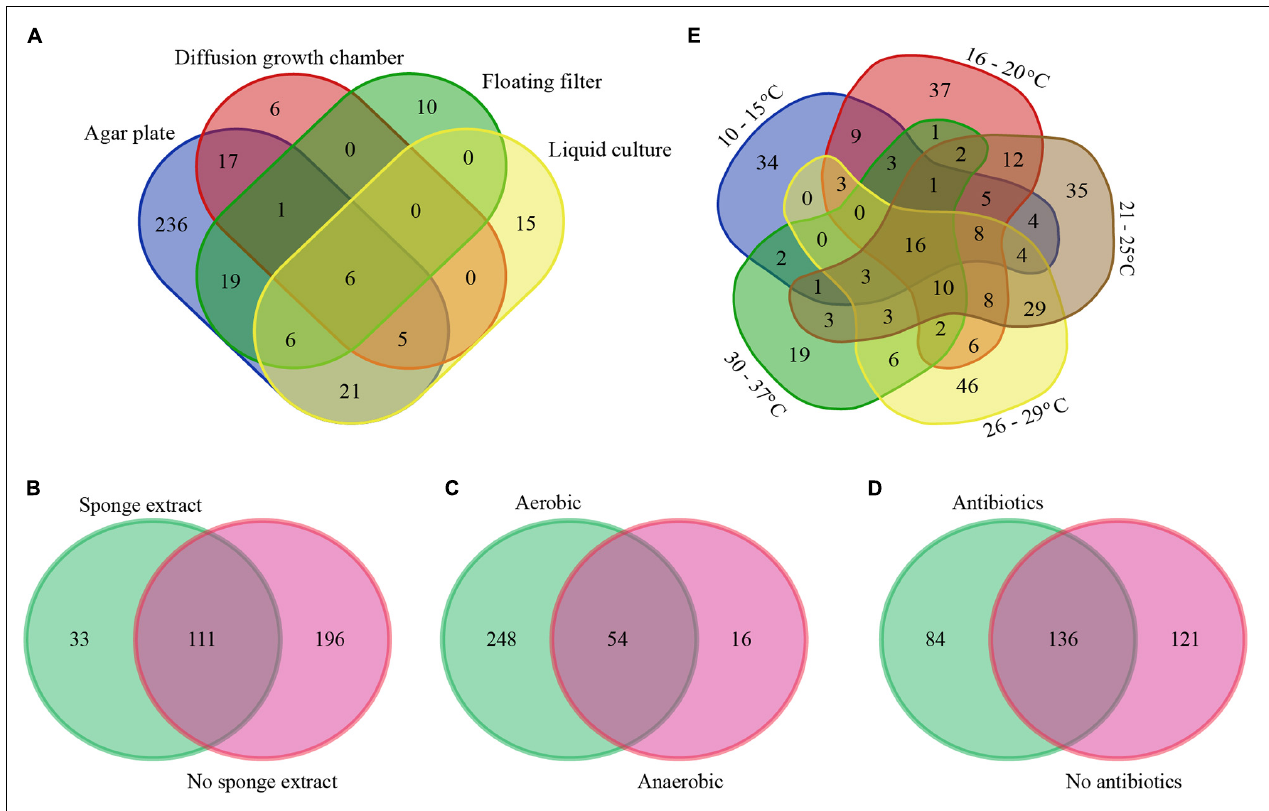
FIGURE 2 | Venn diagram of sponge-associated bacteria cultured under different conditions: isolation methods (A) , with/without of sponge extracts in culture media (B) , with/without oxygen (C) , with/without antibiotics in culture media (D) , and temperatures (E) at genus level. The numbers in the figure indicate the number of